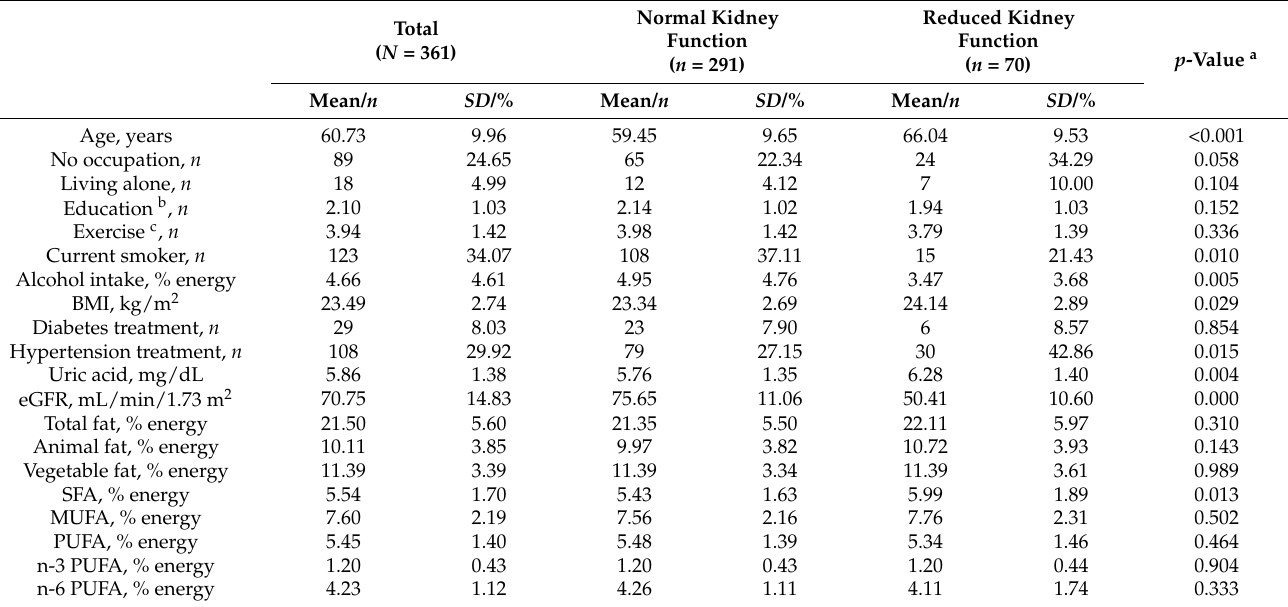
Table 1. Participant